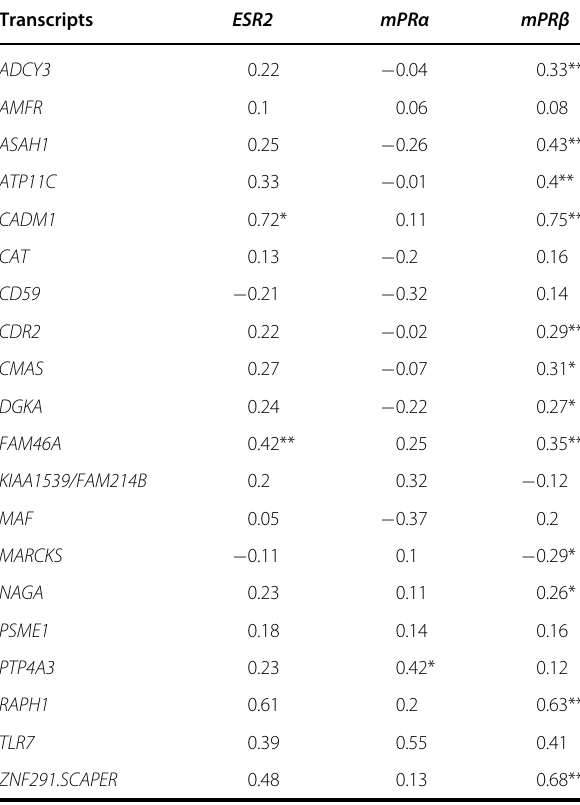
Table 5 Mixed effects model to evaluate association between biomarker transcript levels and expression of estrogen receptor 2 ( ESR2 ), membrane progesterone receptor alpha ( mPR α ), and beta ( mPR β ) in pregnant women.